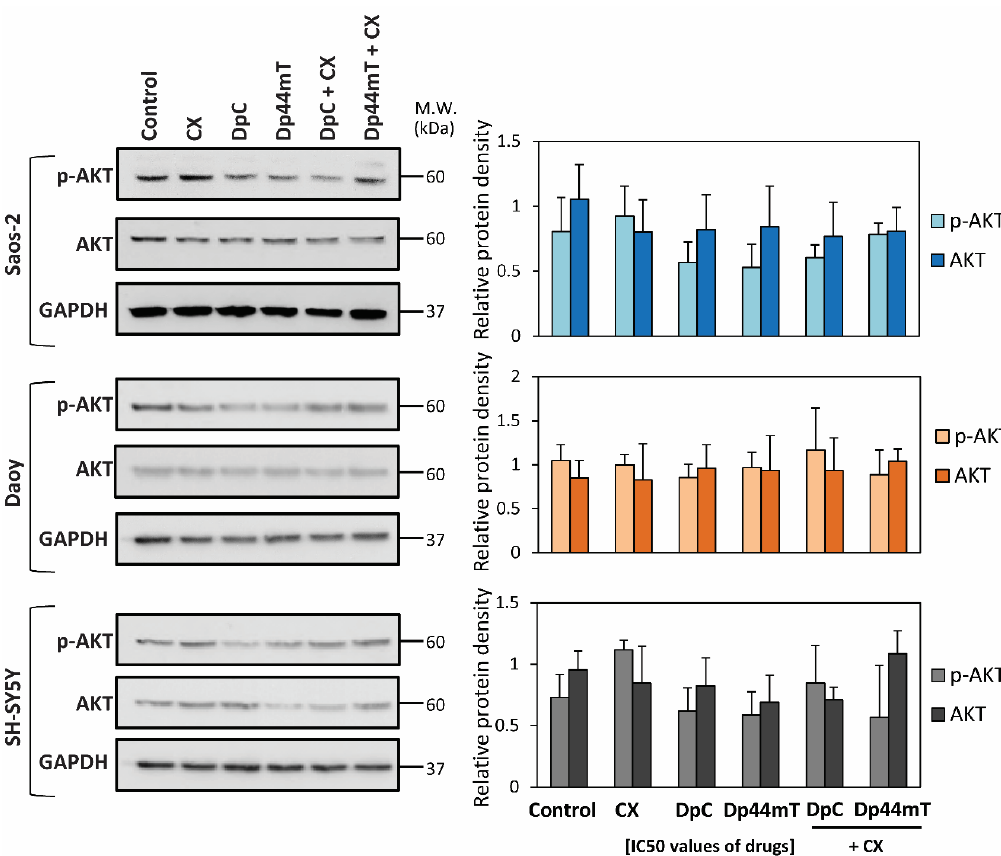
Figure 3. Changes in p ‐ AKT (Ser473) level and total AKT protein expression after a 2 h/37 °C incubation of DpC, Dp44mT, CX alone, or the combinations of DpC and CX, or Dp44mT and CX (concentrations at IC 50 levels; Table 1). Western blot analysis of p ‐ AKT and total AKT using Saos ‐ 2, Daoy or SH ‐ SY5Y cells incubated with control medium or this medium containing CX, thiosemicarbazones, or thiosemicarbazones combined with CX. GAPDH served as a loading control. The experiments were repeated at least three times with quantitation being the results. Western blots are typical of three experiments, while the quantitation of the blots is presented as mean ± SD (3 experiments). These data were analyzed using an unpaired Welch’s t ‐ test followed by the Games ‐ Howell post hoc test.